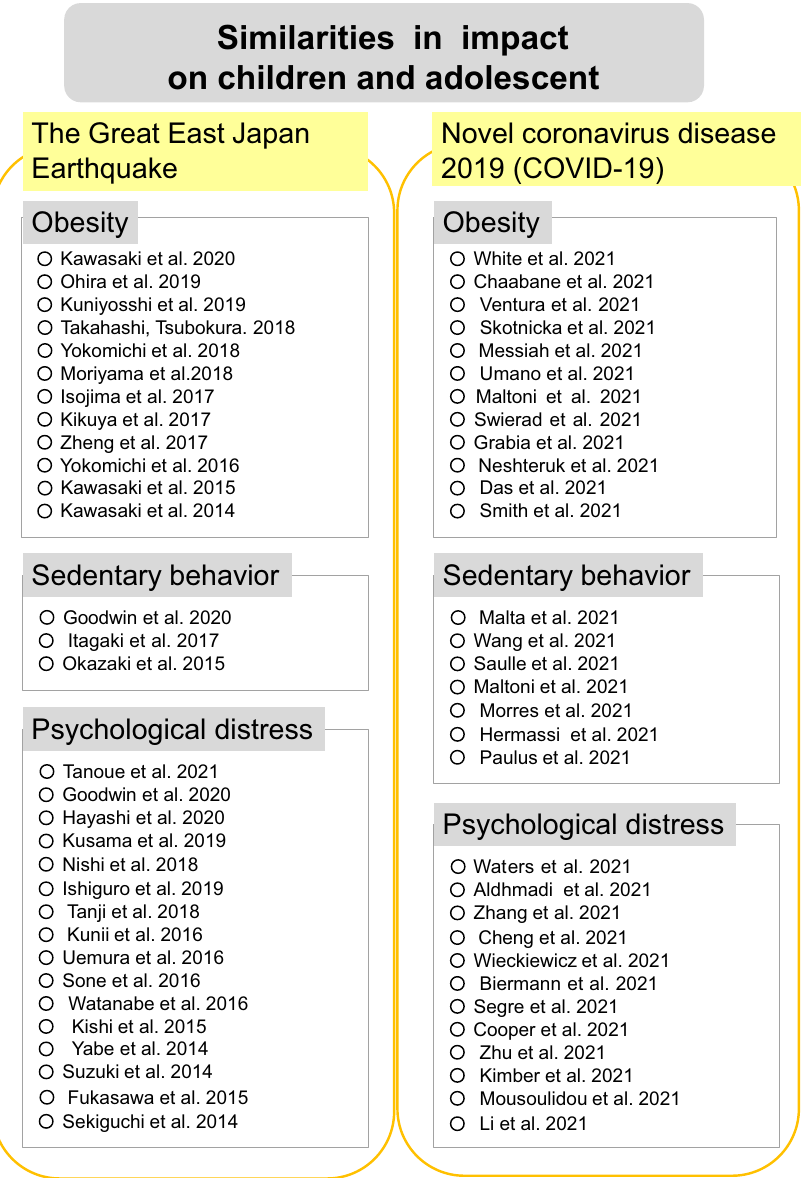
Fig. 1 Adolescent homology during the COVID-19 pandemic and after the Great East Japan earthquake. On the right “ The Great East Japan Earthquake ” gives the articles on children and adolescents after the Great East Japan Earthquake, and on the left “ Novel coronavirus disease 2019 (COVID-19) ” gives the articles on children andadolescents under the COVID-19